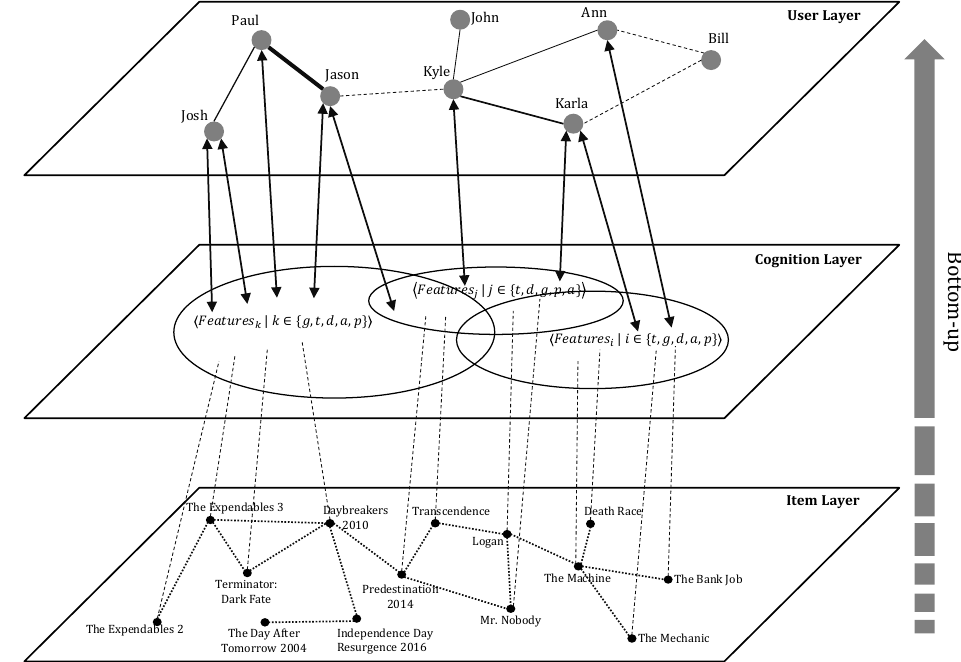
Figure 3. A three-layered architecture for cognitive